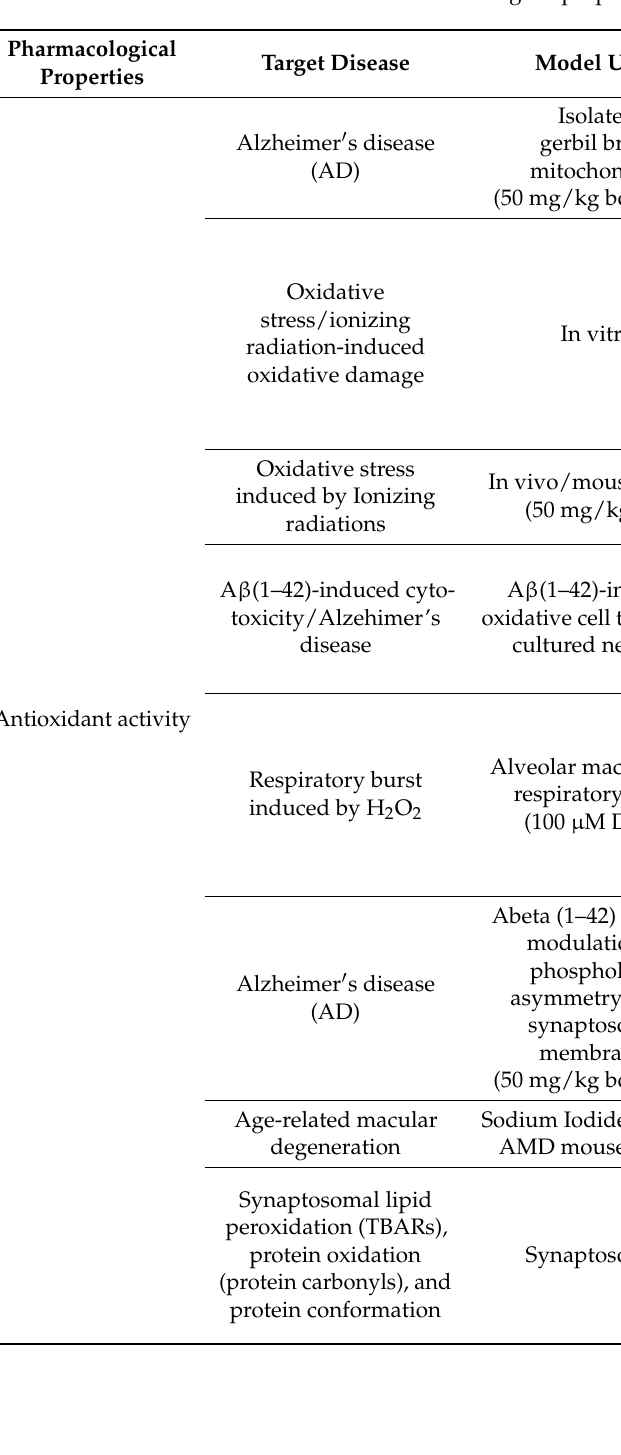
Table 1. Pharmacological properties of